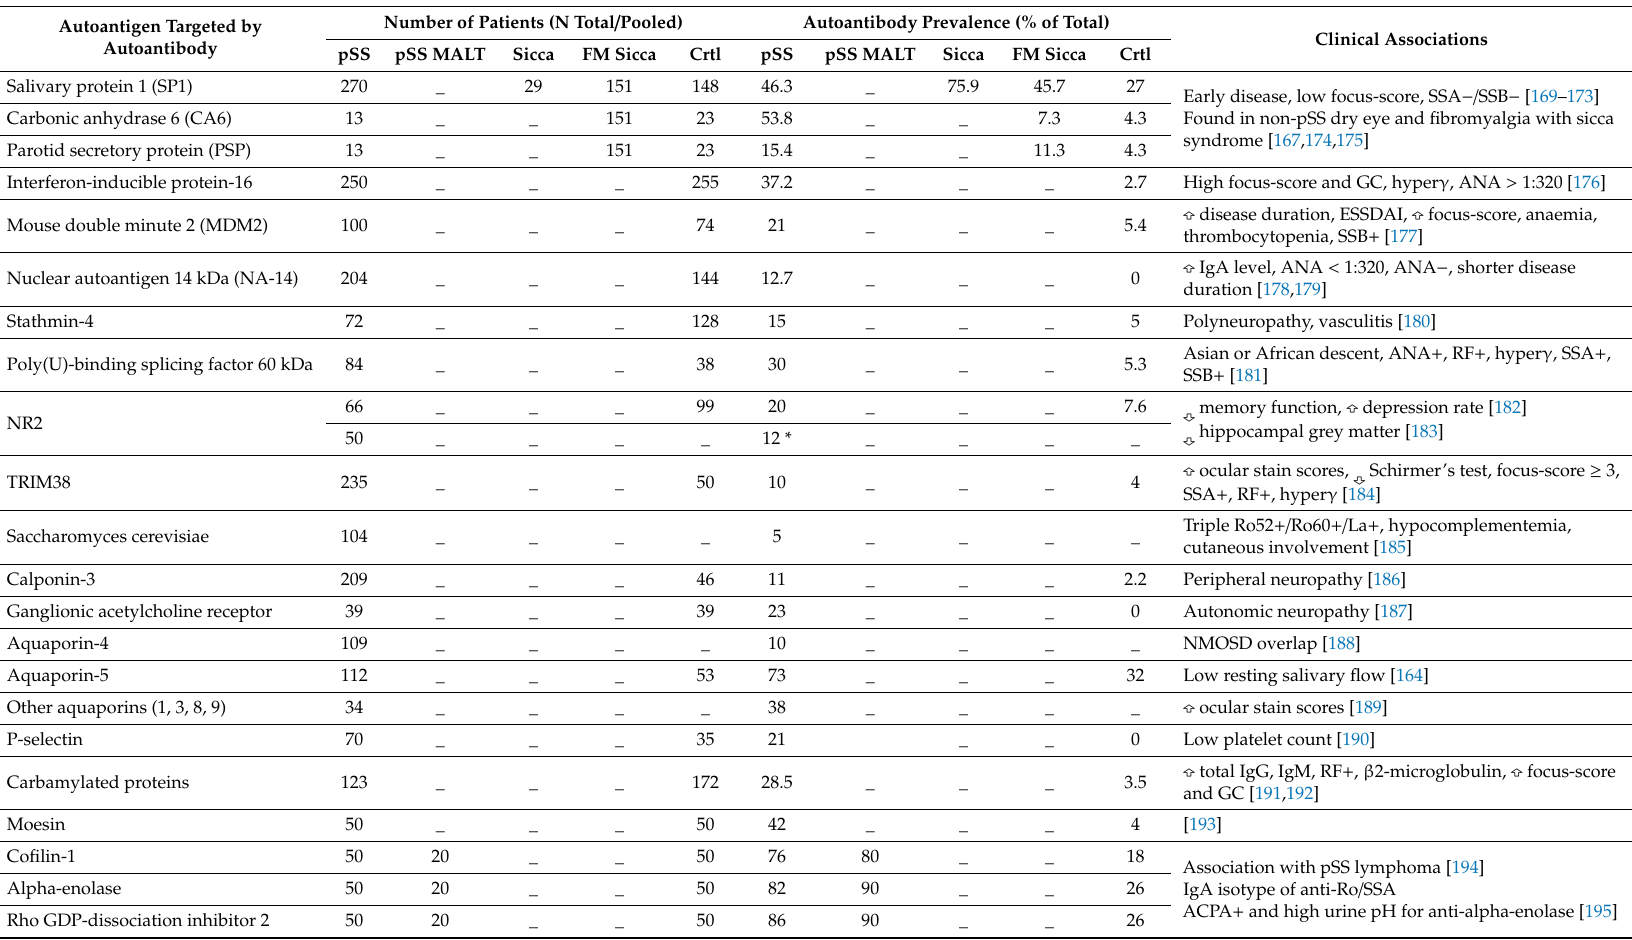
* = antibody positivity in cerebrospinal fluid; Sicca = non-pSS Sicca syndrome; FM = fibromyalgia with non-pSS sicca syndrome similar to “Sicca Asthenia Polyalgia” syndrome; Crtl = healthy controls; hyper γ = hypergammaglobulinemia; ANA = antinuclear antibodies; GC = germinal centre; SSA and SSB = anti-Ro / SSA (Ro52 and / or Ro60) and anti-La / SSB; ESSDAI = Eular Sjögren Syndrome Disease Activity Index; RF + = rheumatoid factor positivity; NMOSD = Neuromyelitis Optica Spectrum Disorder; ACPA + = anti-citrullinated protein antibodies